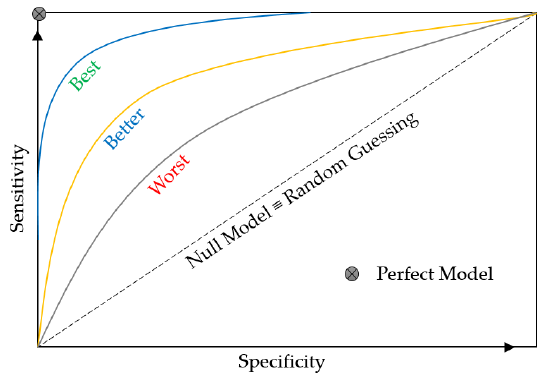
Figure 10. Detailed representation of REC curves.